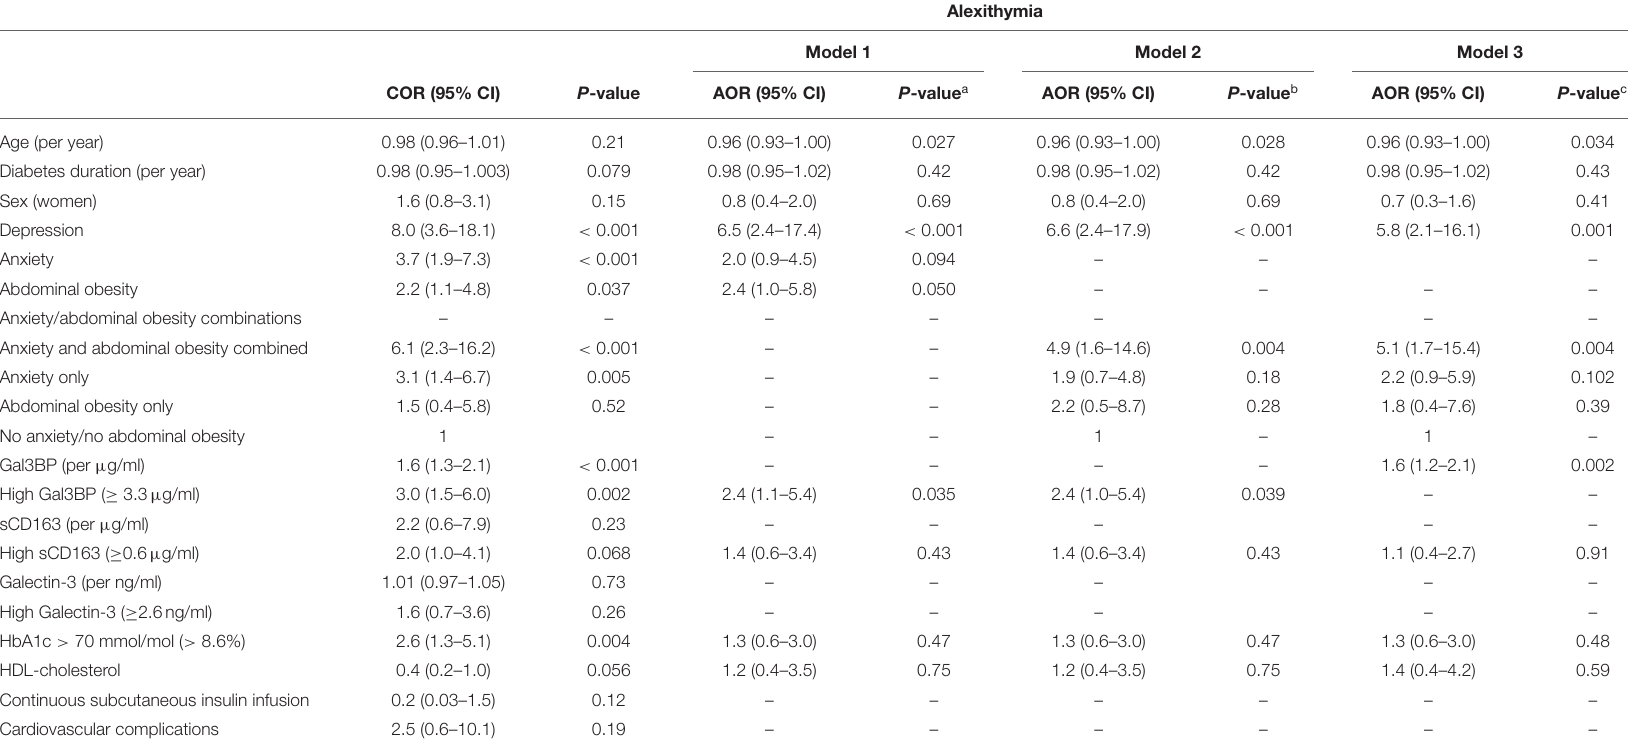
TABLE 3 | Associations with alexithymia in 292 T1D patients explored for three different